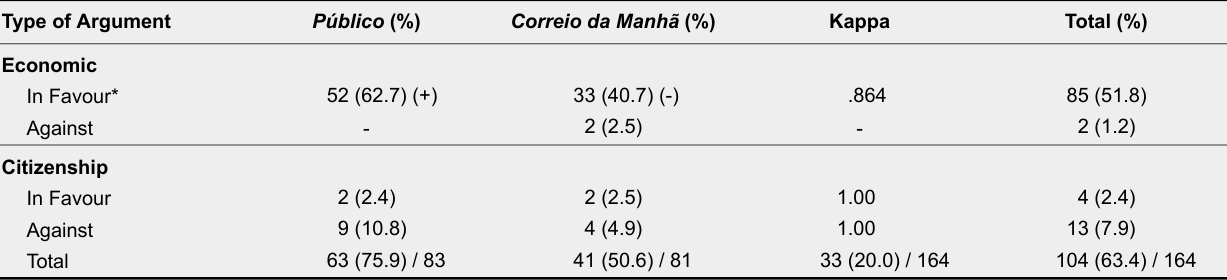
Frequencies and Chi-Square Test of Articles With Arguments Using Economic or Citizenship Values in Favour of or Against Investment Visas, by Type of Press, and Kappa of Random 20% Selection of the